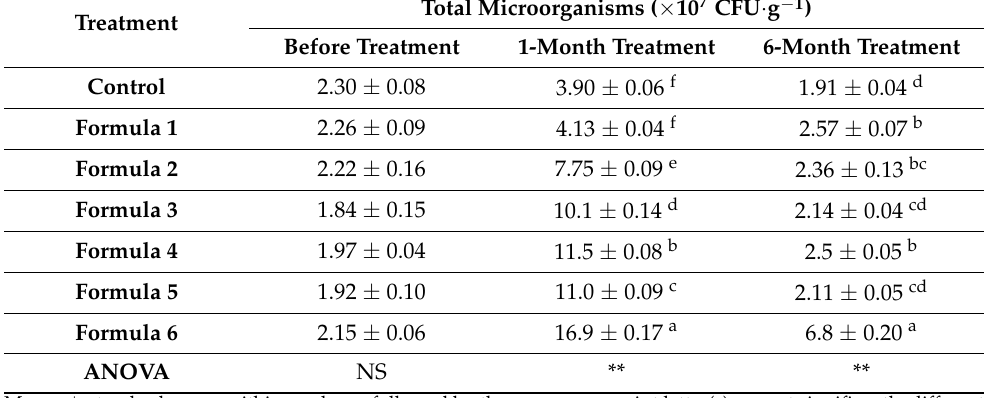
Table 3. Effects of microbiological bio-products on total microorganism density in the soil of a black pepper farm.